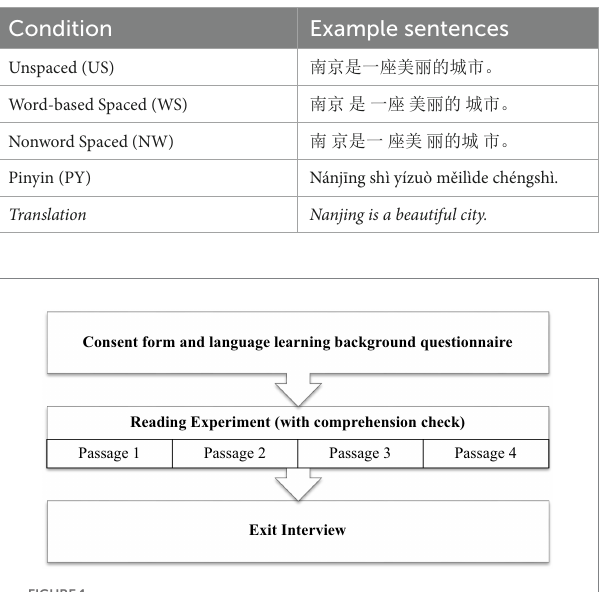
FIGURE 1 Experiment